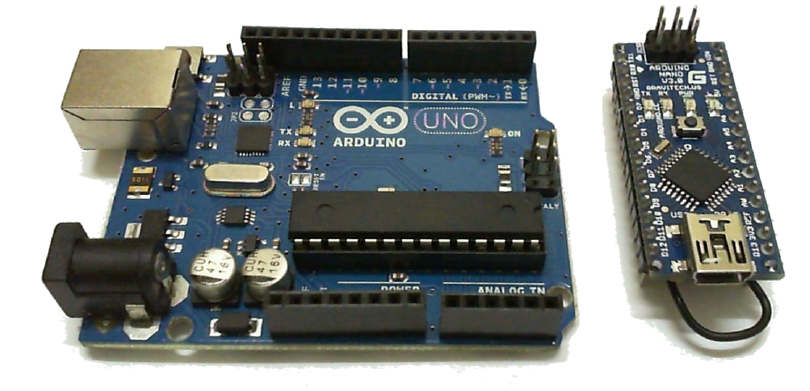
Figure 17. Arduino Nano module ( right ) and Arduino Uno module ( left